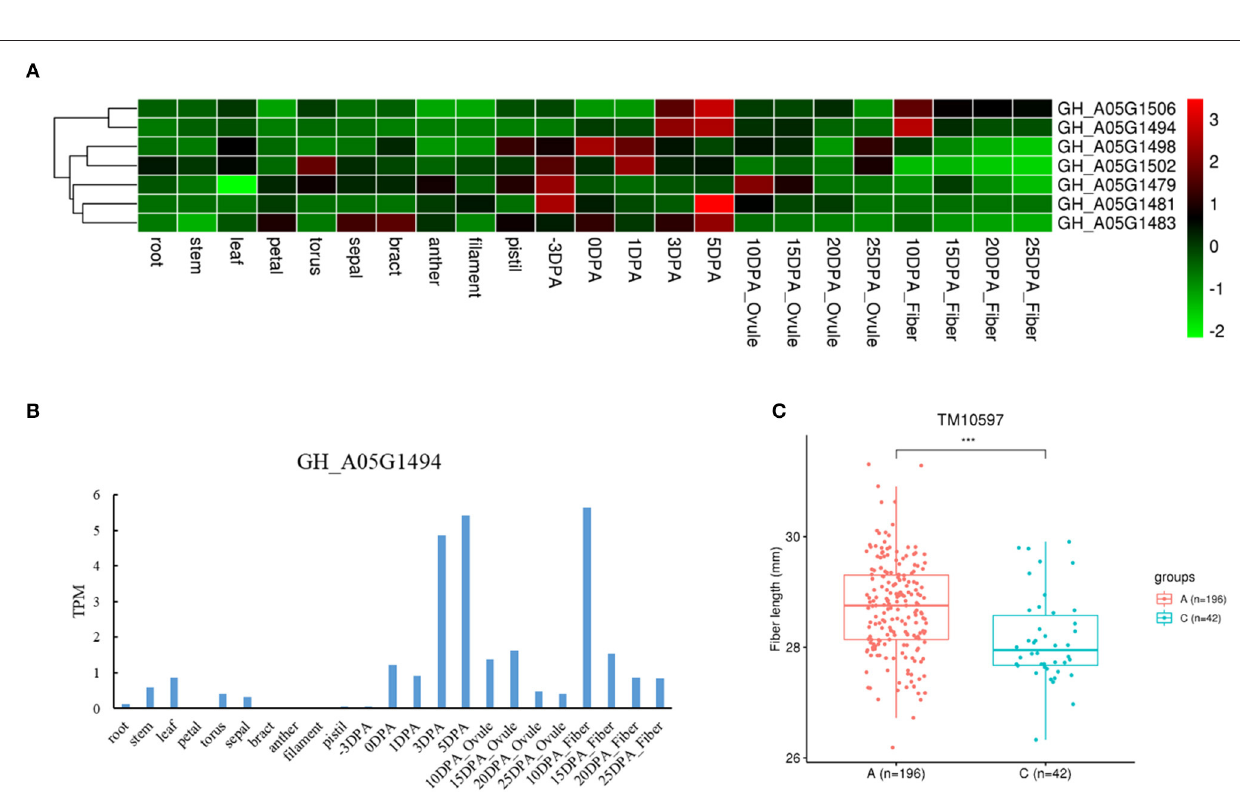
Frontiers in Plant Science |